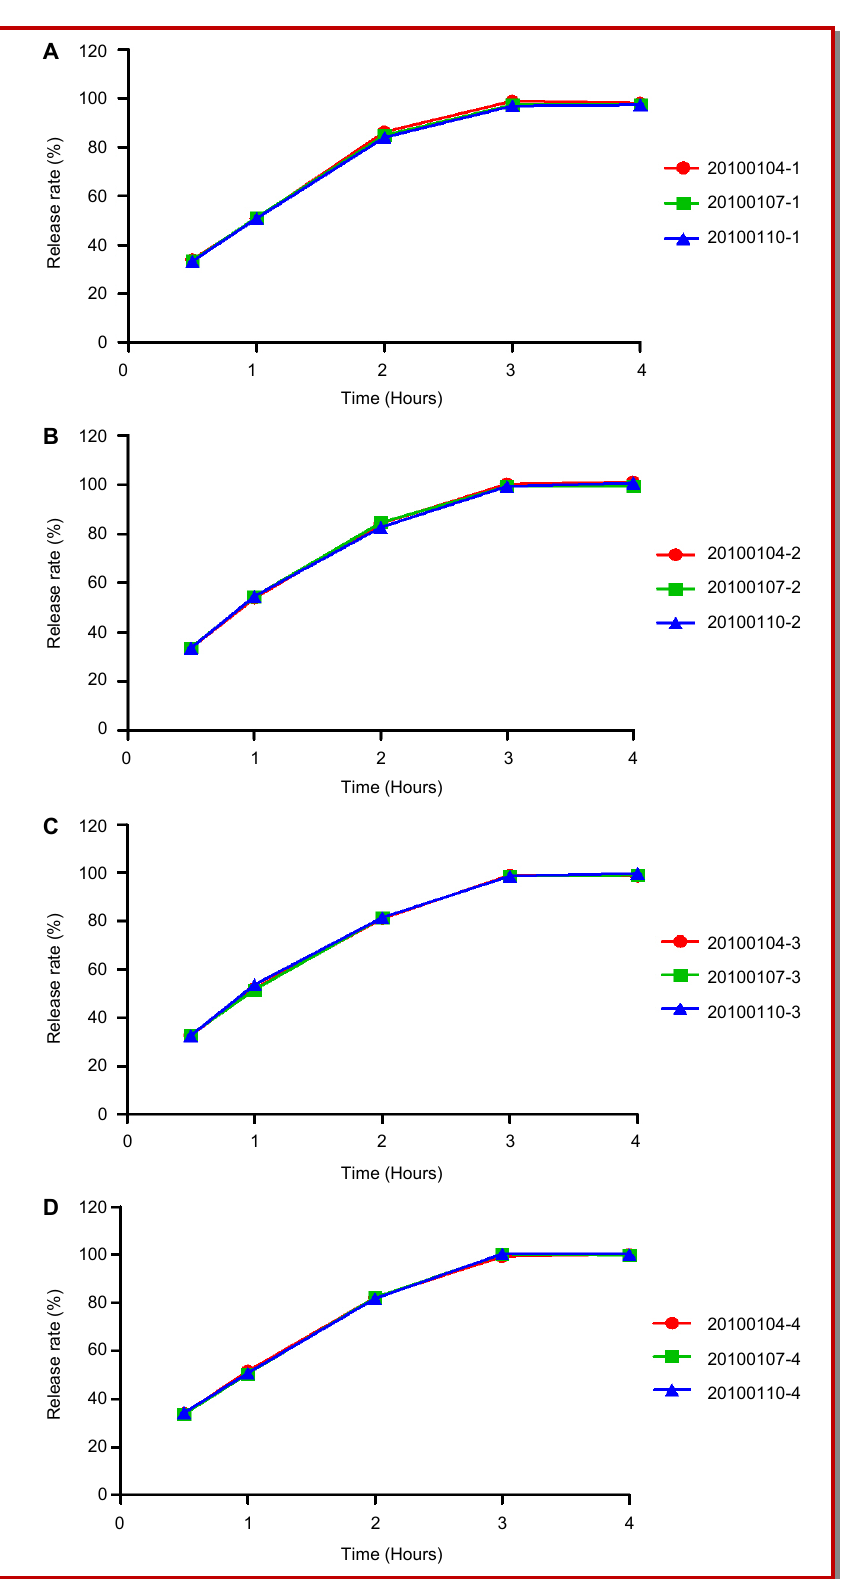
Figure 4: The release curves of the sustained-release capsules in different standard, A: 45 mg, B: 65 mg, C: 90 mg, D: 115 mg. Each point represents average ± standard deviation